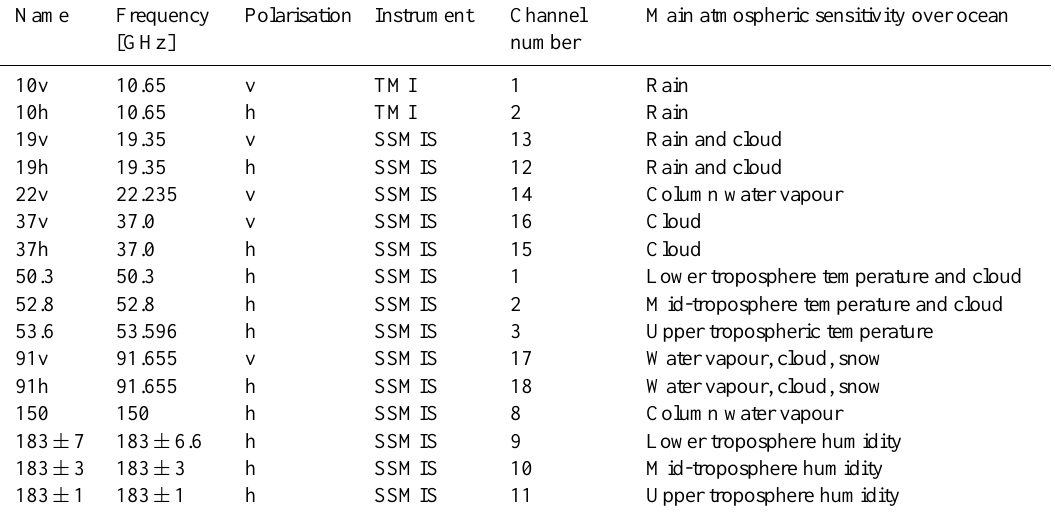
Upper troposphere